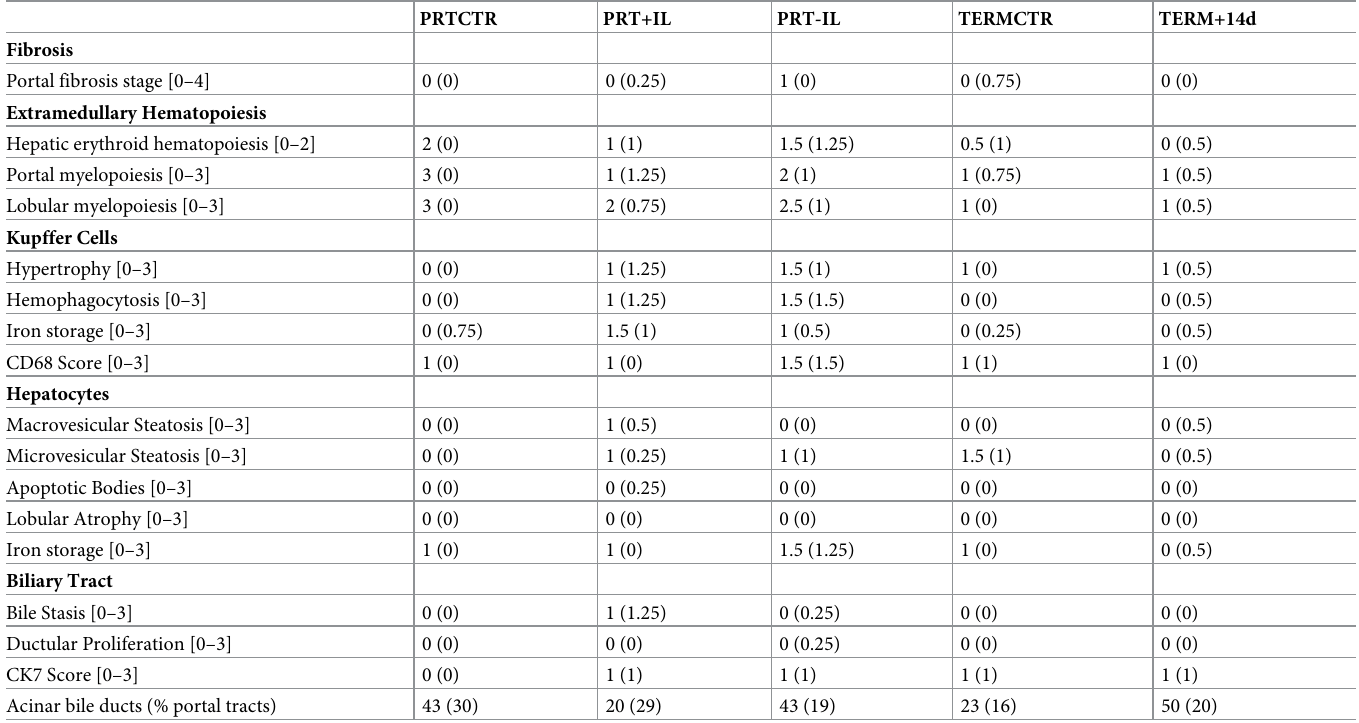
Table 3. Liver histopathology scores in infant baboons.